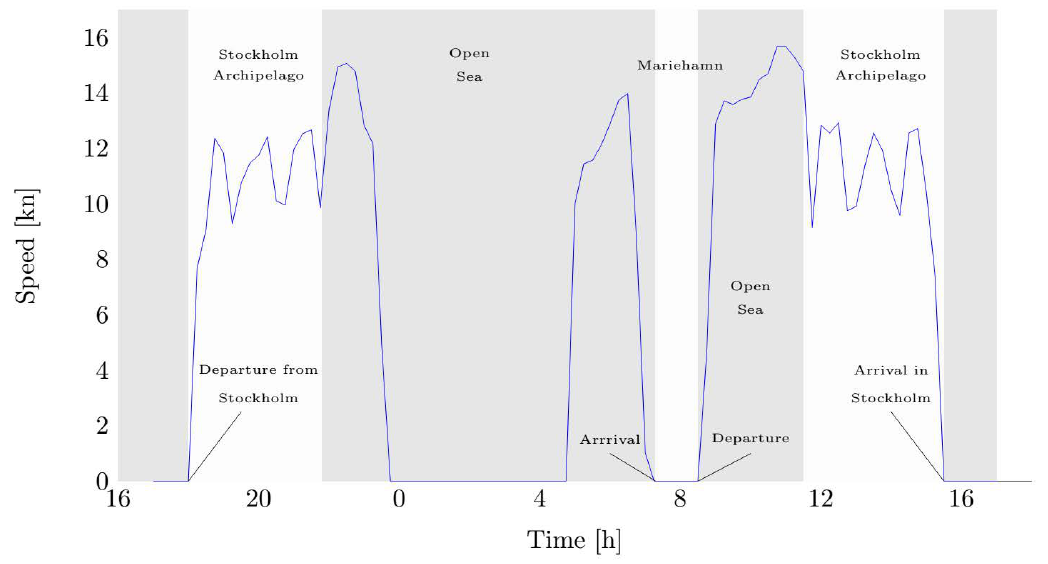
Figure 1. Reference operational profile (ship speed vs. time) for the case study. The two-way voyage from Stockholm to Mariehamn typically includes two stops in port, one period of stationing at sea during night, and two main sailing parts.